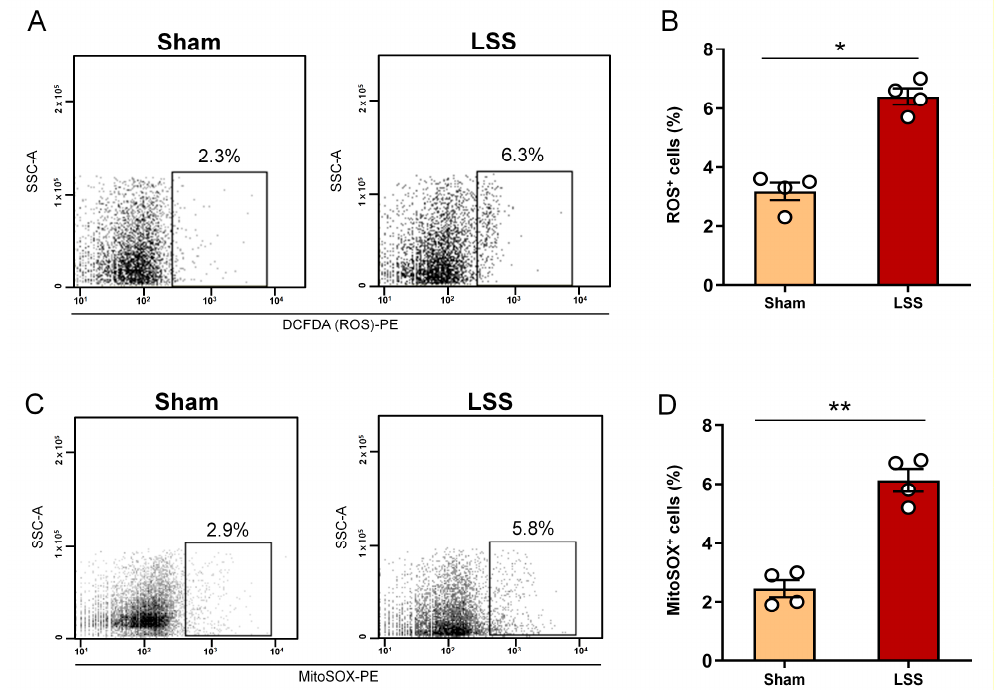
Figure 4. Analysis of cellular ROS and mitochondrial ROS production within CSF after LSS. ( A ) Representative flow cytometry dot blot of the ROS production in sham and LSS models using the FSC parameters. ( B ) Flow cytometric quantification of cellular ROS level within the CSF in sham and LSS groups. ( C ) Representative flow cytometry dot blot of the mitochondrial ROS (MitoSOX) in sham and LSS groups using the FSC parameters. ( D ) Flow cytometric quantification of MitoSOX within the CSF in sham and LSS groups. Data are expressed as the means ± SEM. Significant differences indicated as * p < 0.05 and ** p < 0.01 vs. the sham group were analyzed via unpaired t test with Welch’s correction.